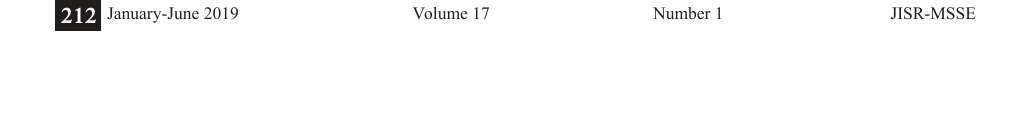
Data retrieved from www.tradingeconomics.com on 5th Nov.